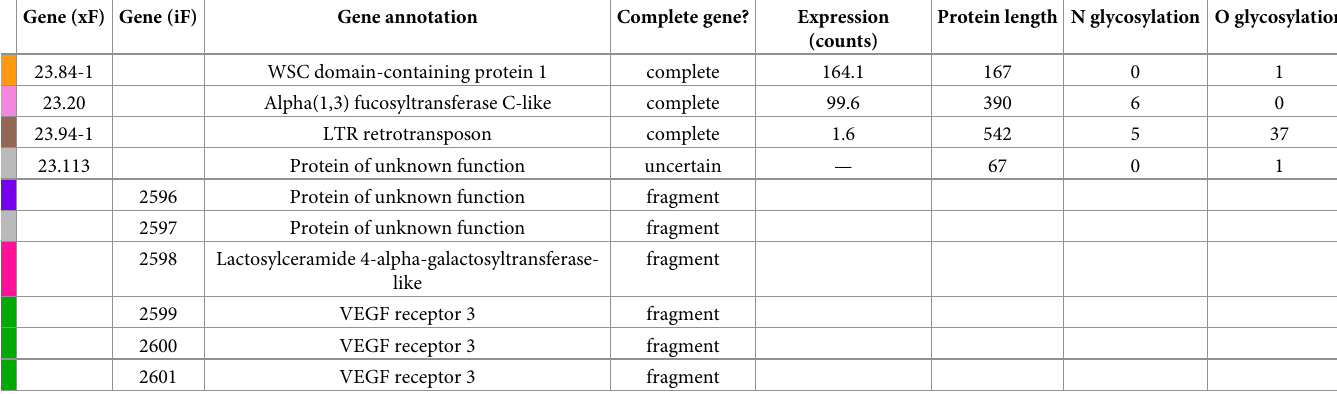
Table 1. Private genes within the F-locus region of the QTL parent